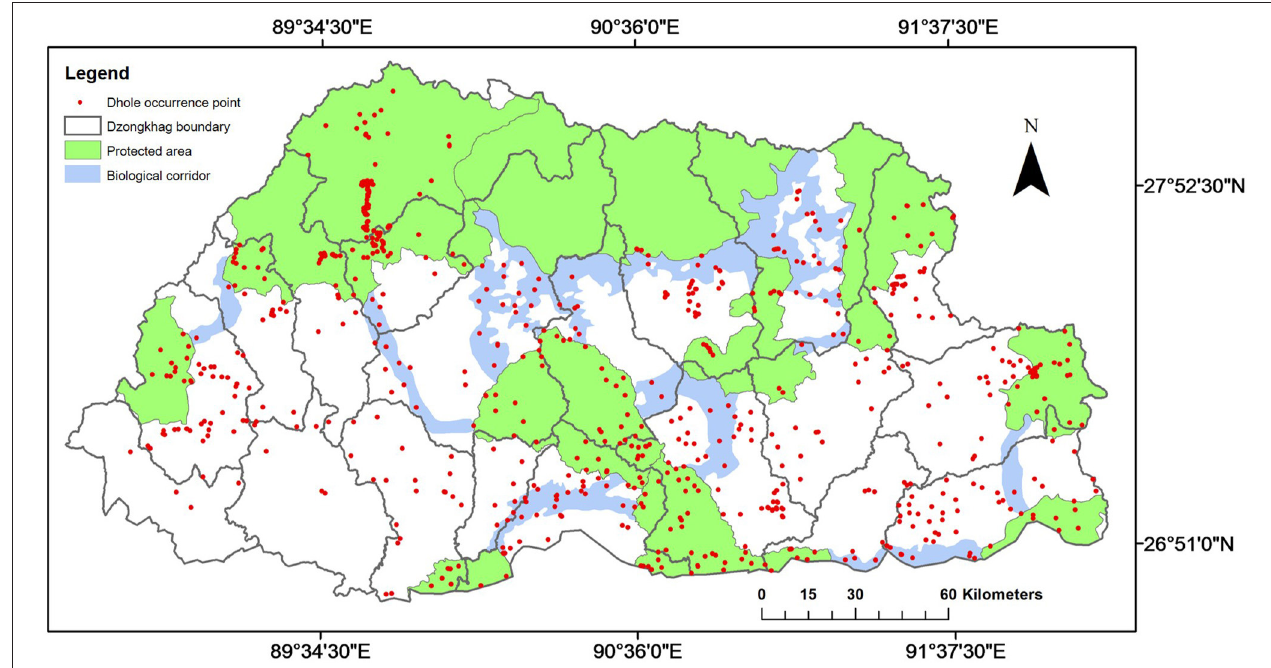
FIGURE 2 | Dhole ( Cuon alpinus ) presence records overlaid on protected areas, biological corridors, and dzongkhags (districts) of